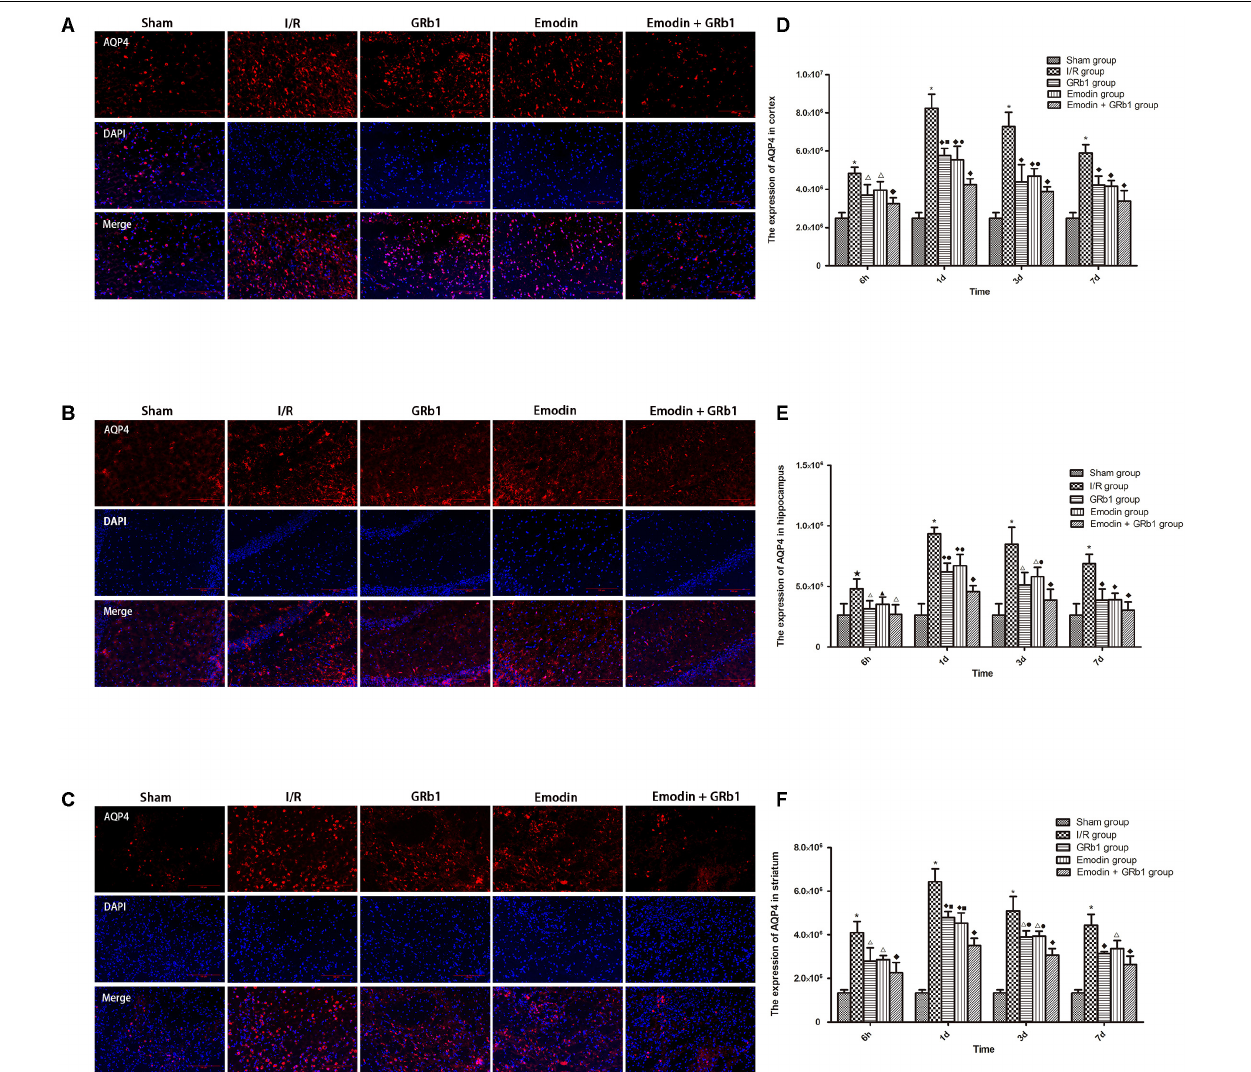
FIGURE 4 | Immunofluorescence staining of AQP4 in I/R rats (mean ± SD, n = 5). (A–C) The expression of AQP4 in (A) cortex, (B) hippocampus, and (C) striatum with immunofluorescence staining. (D,E) Quantitative analysis for the results of (A–C) . One-way analysis of variance (ANOVA) was used for multiple group experiments comparisons and followed by Dunnett test for comparison of two groups within the multiple groups. (cid:70) p < 0.01, ∗ p < 0.001, compared with Sham group. (cid:78) p < 0.05, (cid:77) p < 0.01, (cid:7) p < 0.001, compared with I/R group. • p < 0.01, (cid:4) p < 0.001, compared with the Emodin+GRb1